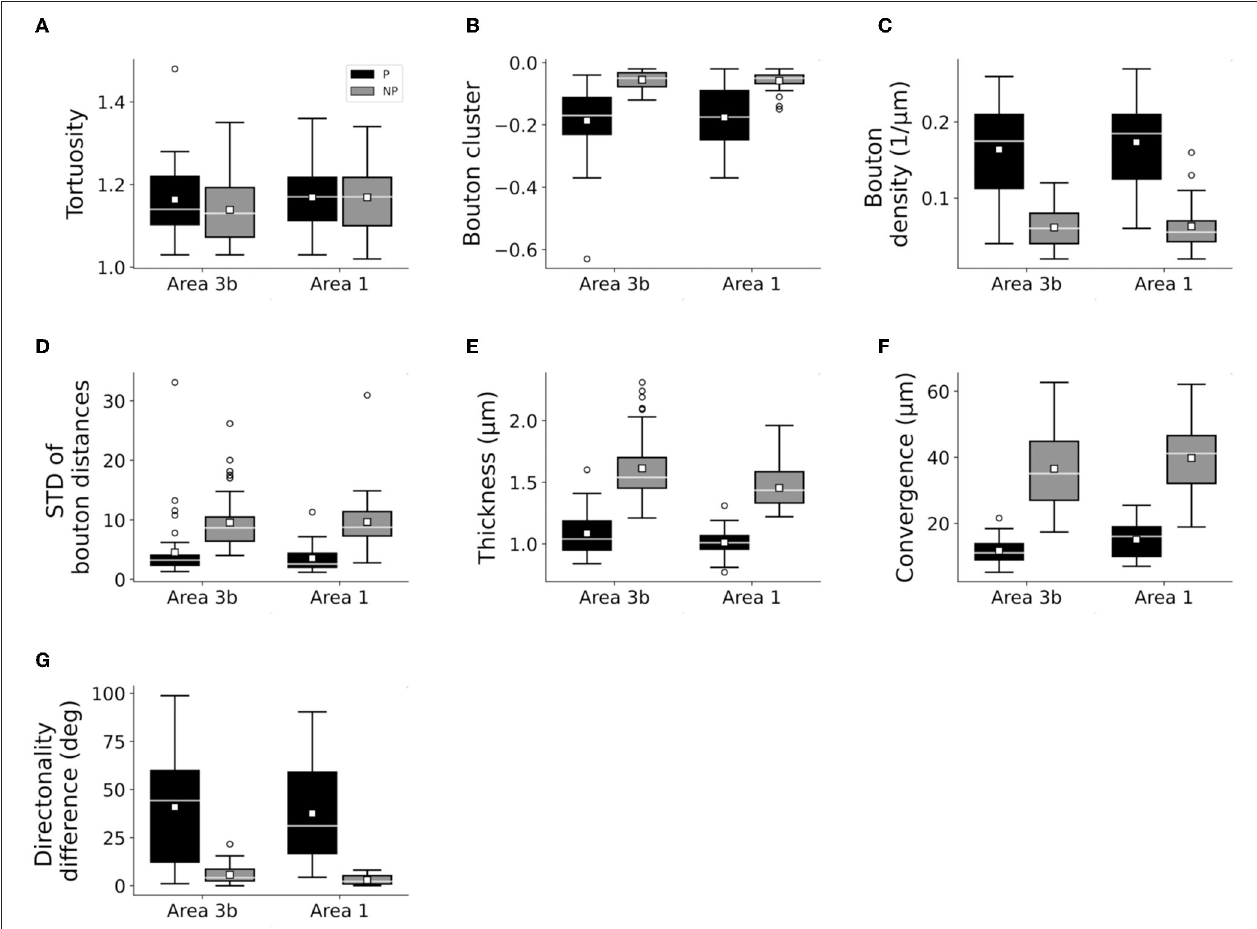
FIGURE 4 | Box plots showing similar characteristics of patch (P) and no-patch (NP) axons following the injection of areas 3b and 1. Area 3b: n = 42 P, 42 NP axons. Area 1: 30 P, and 30 NP axons (A–G) . Conventions are the same as in Figure 3 .